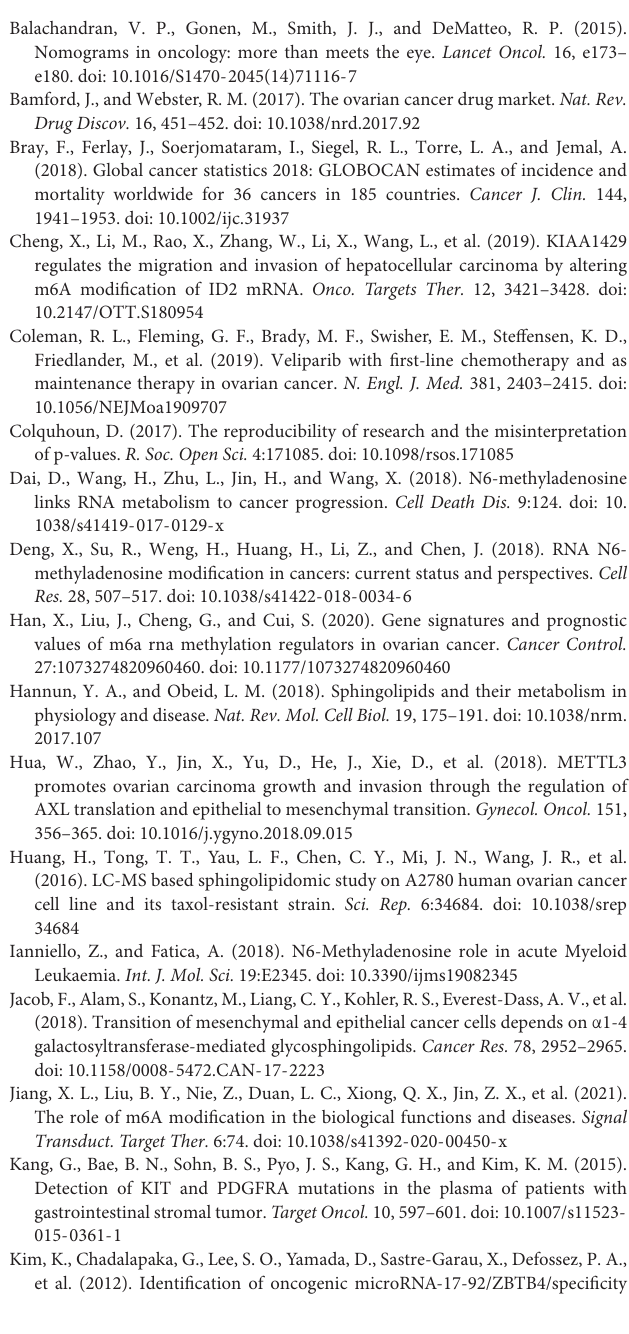
blue represents stage I, yellow represents stage II, red represents stage III, and light blue represents stage IV. For expression levels: red represents high expression, and blue represents low expression). Supplementary Figure 2 | Identification of consensus clusters by m 6 A-related genes. (A) Relative change in area under CDF curve for k = 2–10 classified by m 6 A-related genes. (B) Consensus clustering cumulative distribution function (CDF) for k = 2–10 classified by m 6 A-related genes. (C) Consensus clustering matrix for k =